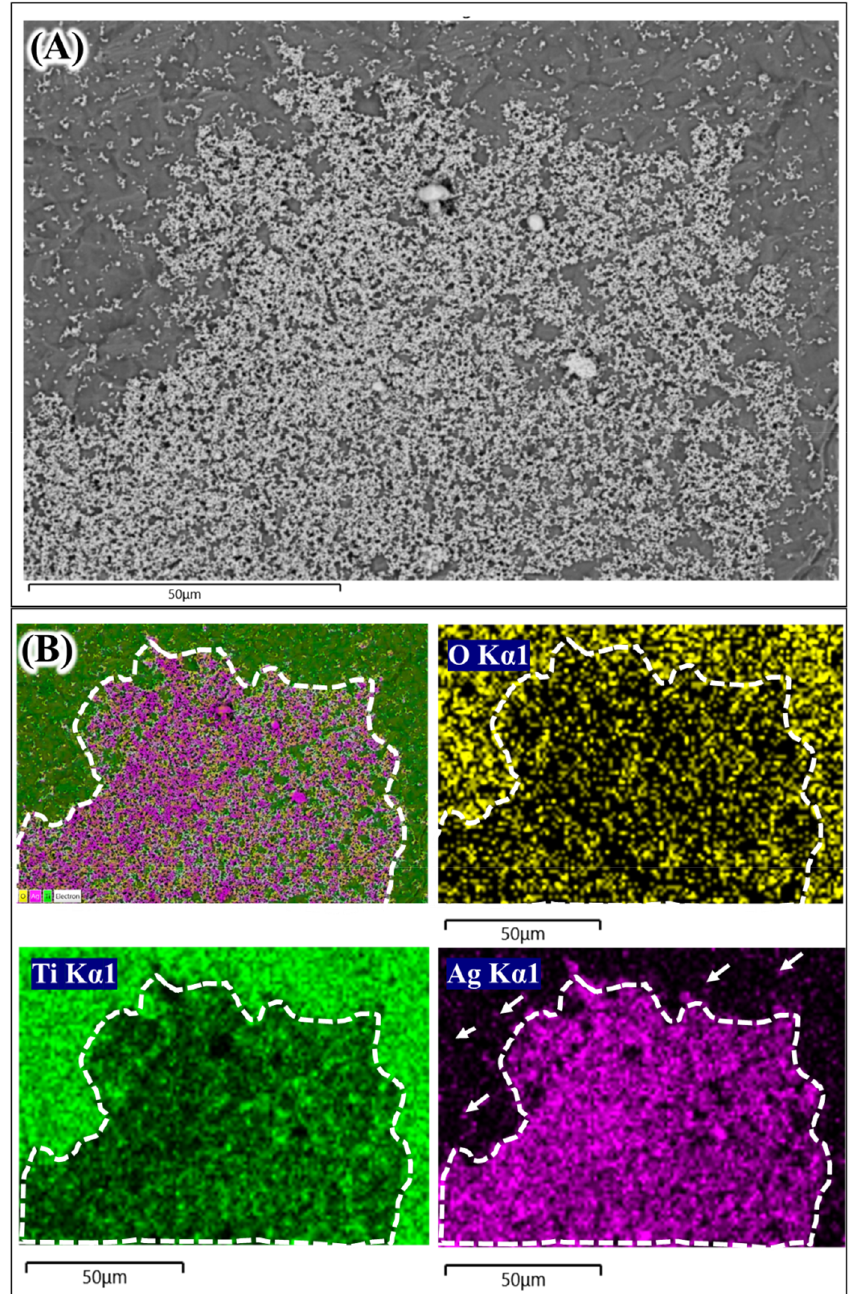
Figure 3. Scanning electron microscope image (A) and energy dispersive X-ray analysis element mapping images of Ag coated Ti from 0.01 mol/L AgNO 3 (B). 14 tothe rest. TheOelemental mapping provided very important data aboutthe deposited Agcoating. The darker area (white dash line; Figure 3) in O elemental mapping indicated that that area was composed mostly of metallic Ag. Ag oxide also existed since the bright yellow color was also observed sporadically inside the white dash line (Figure 3; O K α 1). A similar trend was shown in Figure 4 where the Ag aggregate coating is larger. The thick Ag coating was most likely composed mainly from metallic Ag and smaller portion of Ag 2 O Surface treatment often changes surface roughness. 15 The change in surface roughness might alter the biological performance of Ti implant. Therefore, it is necessary to evaluate whether the current method of Ag coating changed